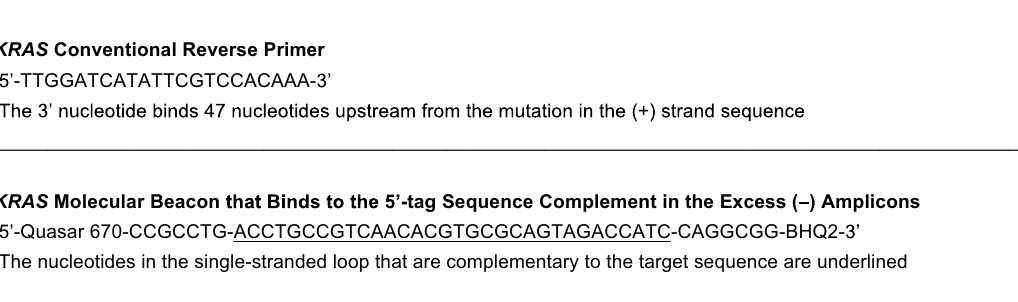
Table 1. Primers and molecular beacon probe for the experiment that compares the use of a pair of SuperSelective primers to the use of a SuperSelective primer and a conventional reverse primer.